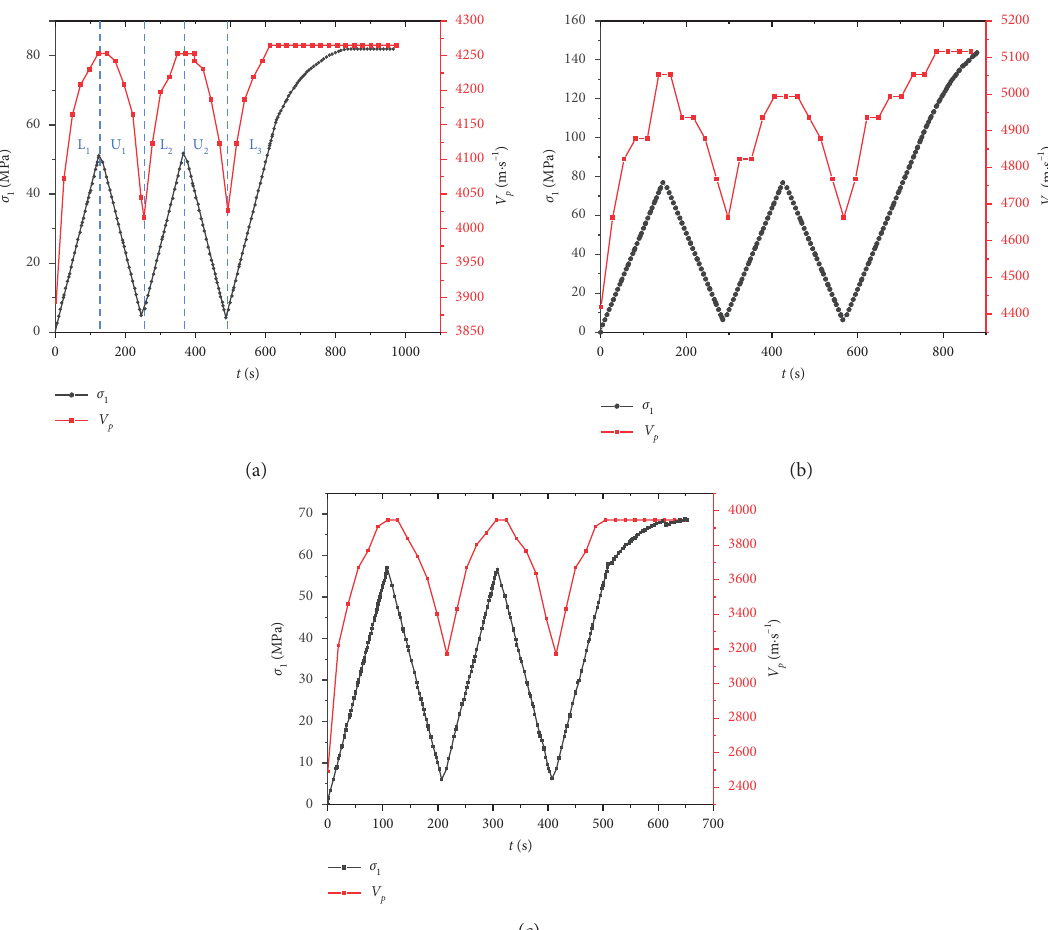
Figure 3: P-wave velocity-stress curves of the sandstone specimens: (a) US1; (b) US2; (c)